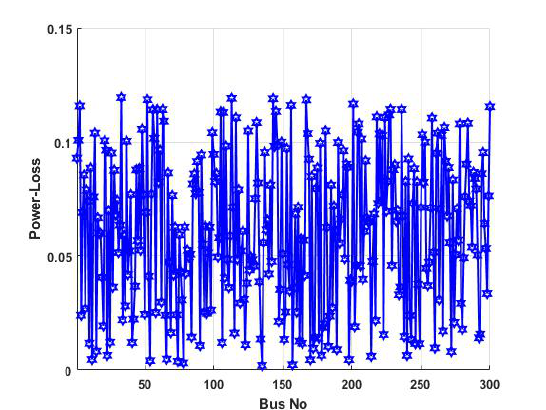
Figure 23. Analysis of Power-loss